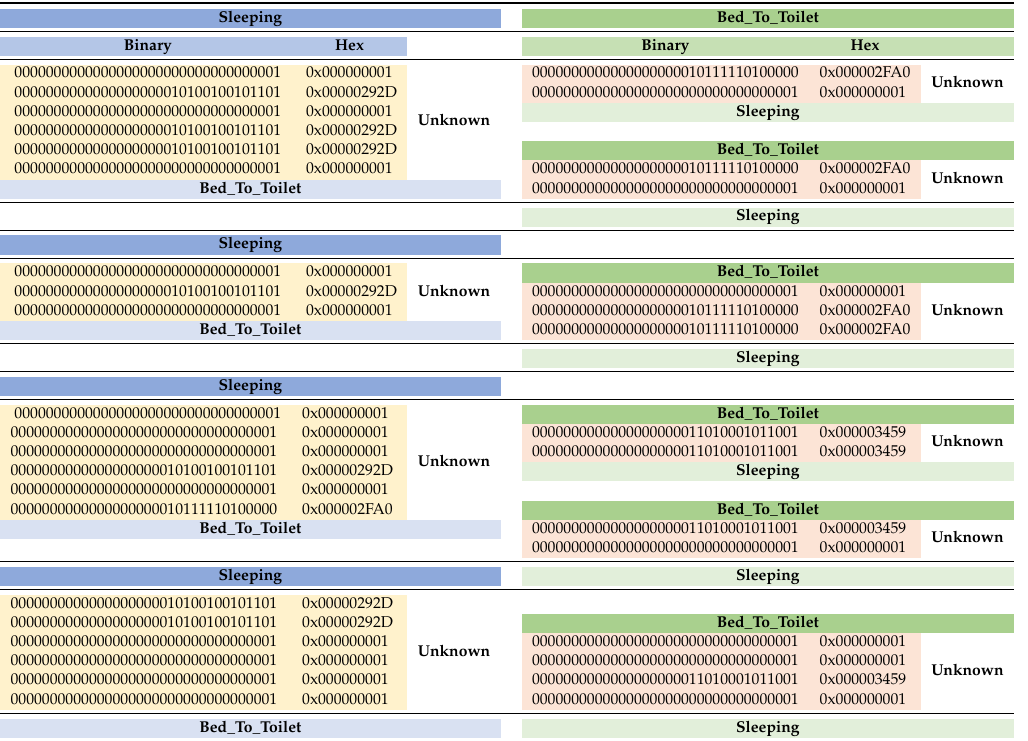
Table 1. Interactivity sensor readings in the annotation